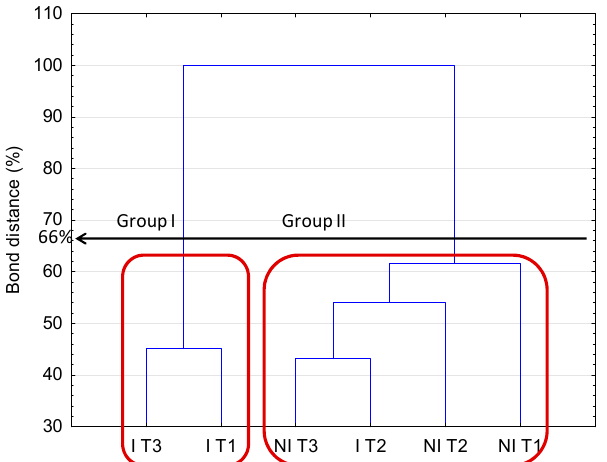
Figure 2. Dendrogram of the bond distances between the carbon utilizations patterns of the substrates on the Biolog EcoPlates TM . Grouping was conducted according to the Sneath’s criterion (66%); NI, non-inoculated; I, inoculated with Rhizobium ; T1, 5–6 leaf stage; T2, flowering; T3, pod formation stage; n = 3. Red frames indicate group treatments with similar carbon utilization.